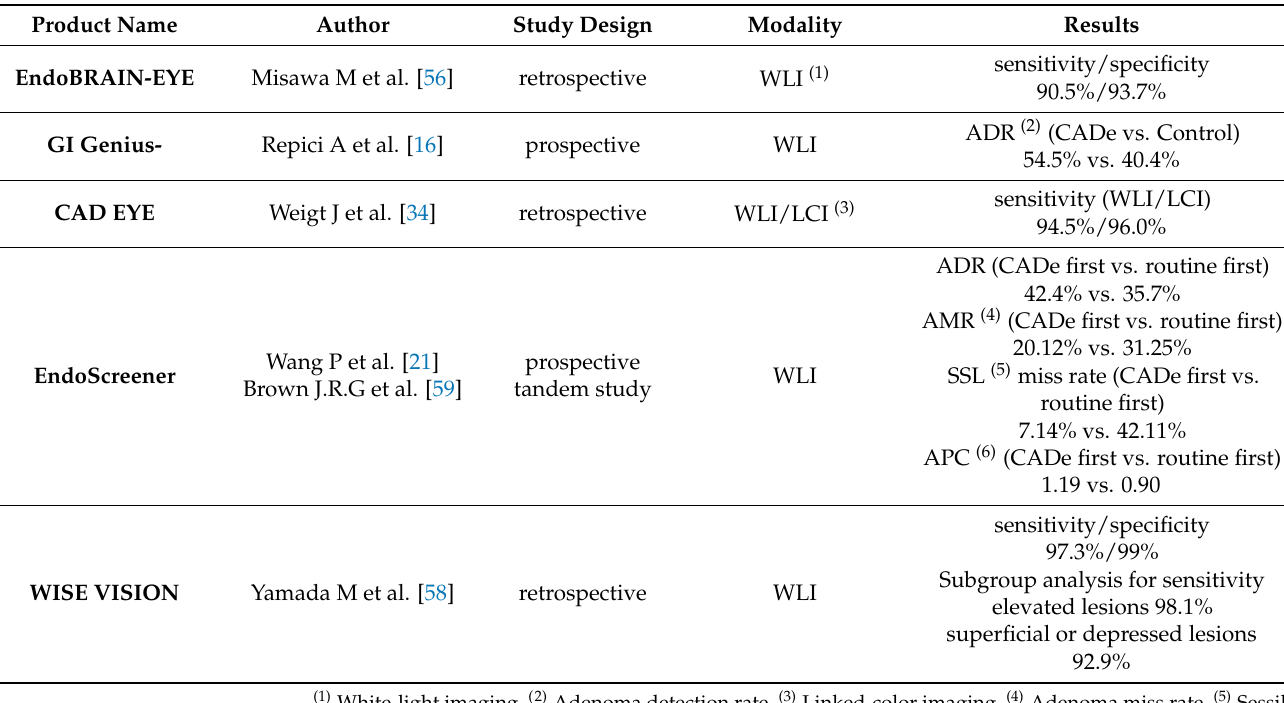
Table 3. Study data of commercial CADe systems.